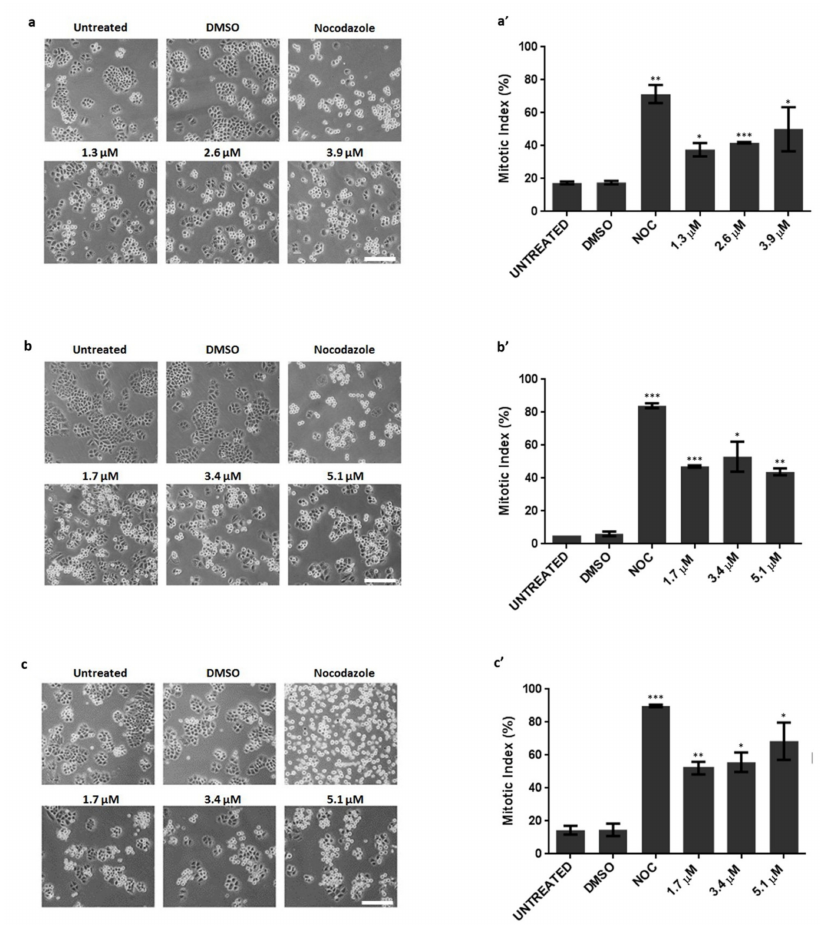
Figure 2. Cancer cells arrested in mitosis, in response to pyranoxanthone 2 (PX2) treatment. Left-Representative phase contrast microscopy images, after 16 h treatment with PX2, at indicated concentrations, displaying accumulation of mitotic cells (rounded) in ( a ) A375-C5, ( b ) MCF-7 and ( c ) NCI-H460 cancer cell lines. Nocodazole was used as a positive control. DMSO was used as a compound solvent control. Bar, 10 µ m. Right-Mitotic index graphs showing accumulation of mitotic cells in ( a’ ) A375-C5, ( b’ ) MCF-7 and ( c’ ) NCI-H460 cancer cells with statistical relevance of * p < 0.05, ** p < 0.01 and *** p < 0.001 by unpaired t